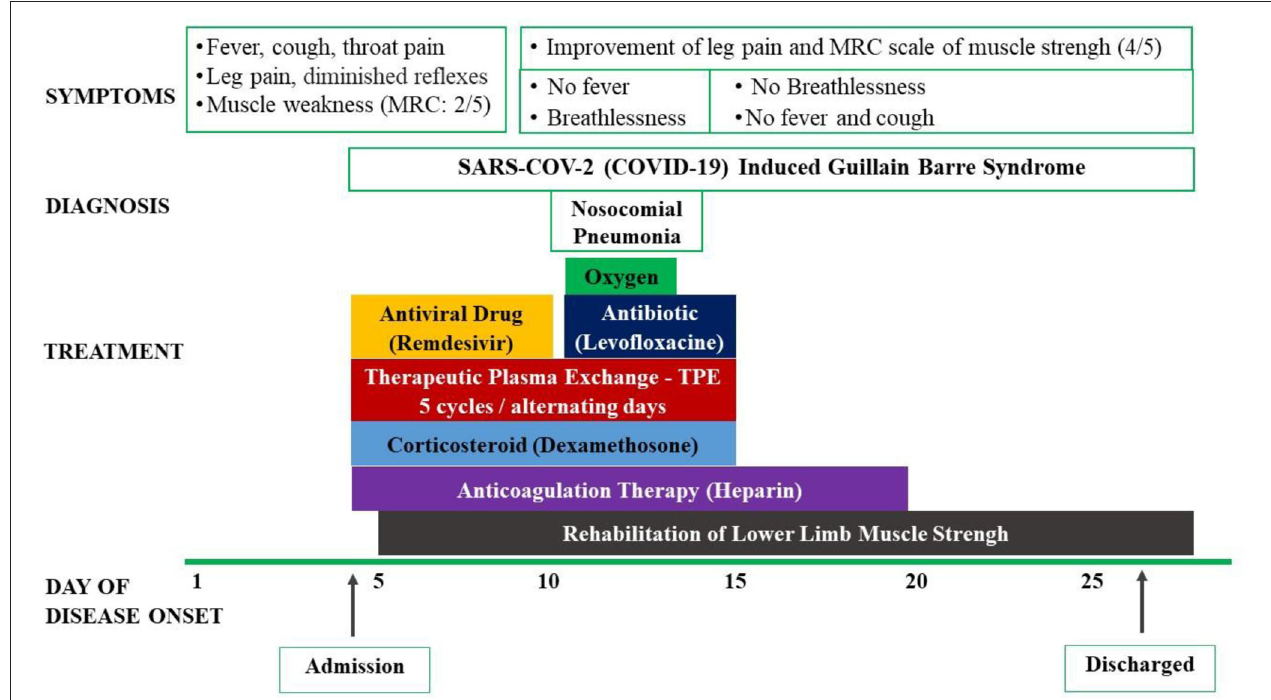
FIGURE 1 | Symptoms, diagnosis, and treatment of reported